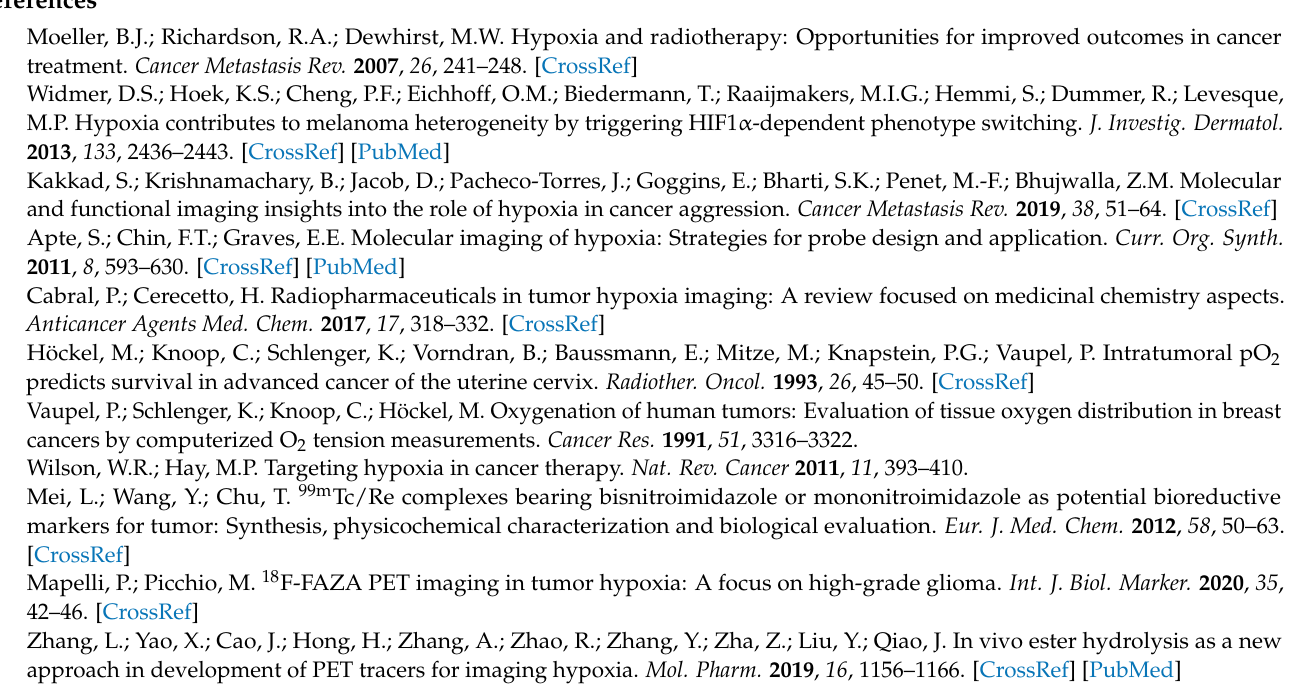
Figure S4: 13 C NMR spectrum of HYNICNM, Figure S5: IR spectrum of HYNICNM, Figure S6: HR-MS spectrum of HYNICNM, Figure S7: HPLC patterns of [ 99m Tc]Tc-Tricine and [ 99m Tc]Tc-Tricine- TPPTS, Figure S8: In vitro stability HPLC profiles of [ 99m Tc]Tc-tricine-TPPTS-HYNICNM, Figure S9: In vitro stability HPLC profiles of [ 99m Tc]Tc-tricine-TPPMS-HYNICNM, Figure S10: In vitro stability HPLC profiles of [ 99m Tc]Tc-(tricine) 2 -HYNICNM, Table S1: Biodistribution of [ 99m Tc]Tc-tricine-TPPTS- HYNICNM, [ 99m Tc]Tc-tricine-TPPMS-HYNICNM, and [ 99m Tc]Tc-(tricine) 2